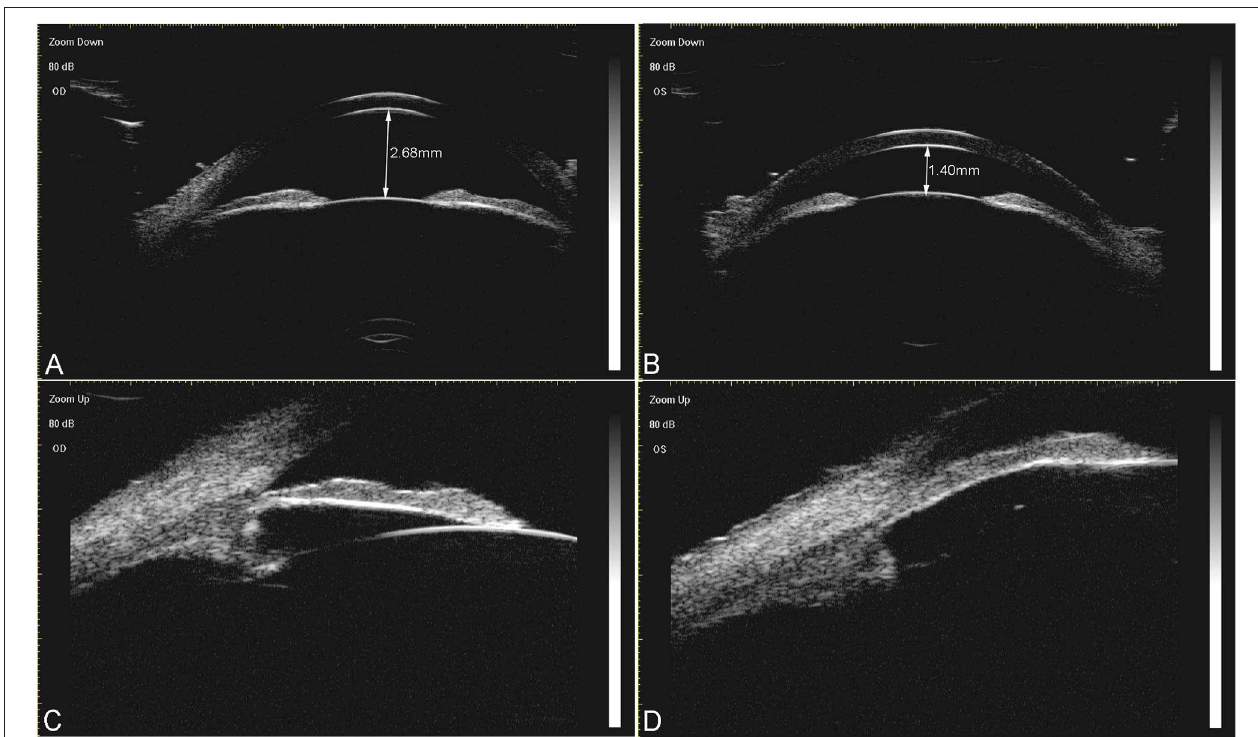
FIGURE 1 | A representative case of acute secondary angle closure associated with the lens subluxation (ASAC-LS) group. A 52-year-old woman had a history of acute angle closure attack in her left eye. The ultrasound biomicroscopy (UBM) images prior to surgery revealed an obvious shallow central anterior chamber depth in her left eye [ (B) , 1.40mm), compared with the right eye [ (A) , 2.68mm]. (C) Illustrates that the angle was open in the right eye. (D) Depicts that the angle was closed in the left eye, the zonule was sparse in each quadrant, and the lens moved forward slightly.